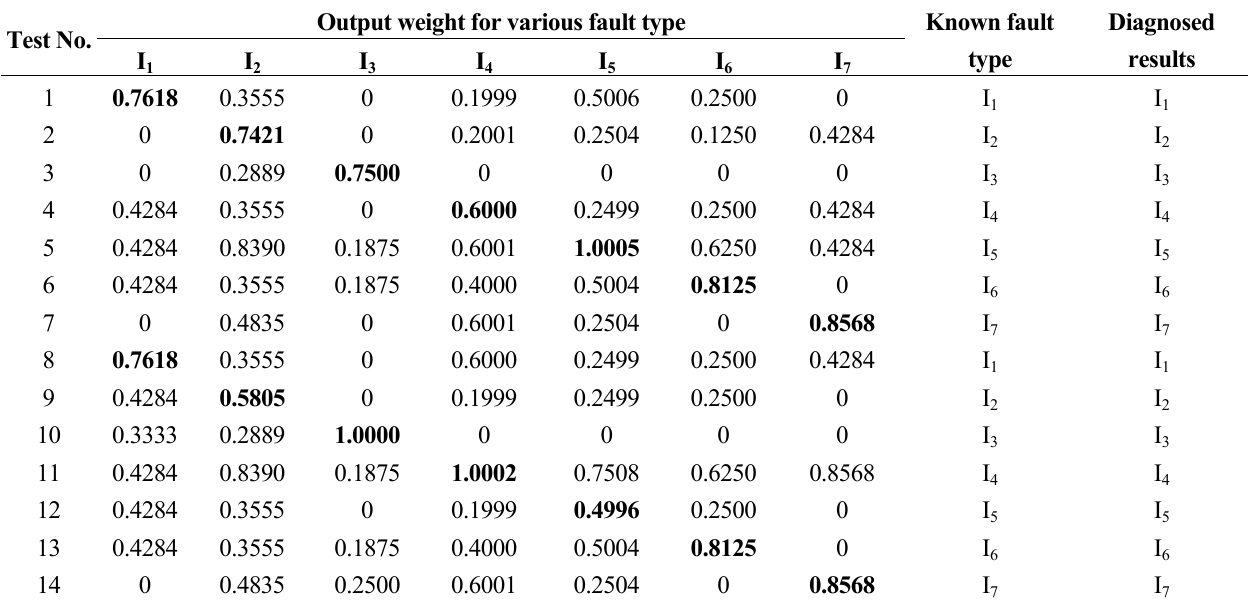
Table 7. Detection results for the test data with added variance.